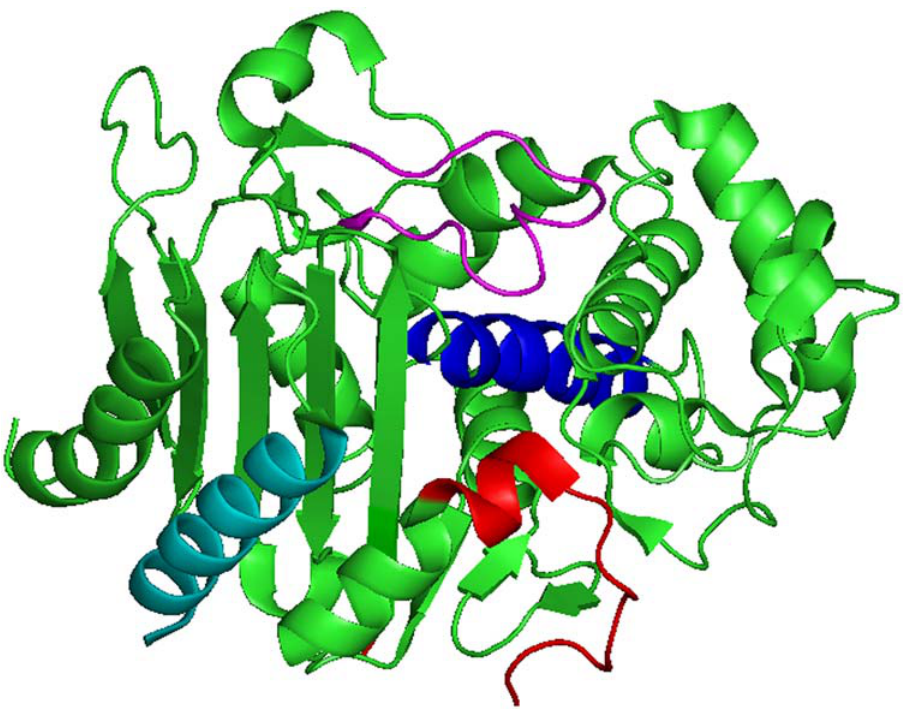
Figure 1. Ribbon diagram of crystallographic structure of CMY-10 (a cESBL). The image was rendered with PyMOL, available on the Internet (http://sourceforge.net/projects/pymol). The R2-loop is represented as red, while the V -loop, H-2 helix, and H-11 helix are depicted in violet, blue, and cyan, respectively. The R1 active site (central upper region) is surrounded by the V -loop and the R2 active site (central lower region) by the R2-loop and H-11 helix. The nucleophile (Ser65), attacking the carbonyl carbon of b -lactam ring, is present in the H-2 helix.